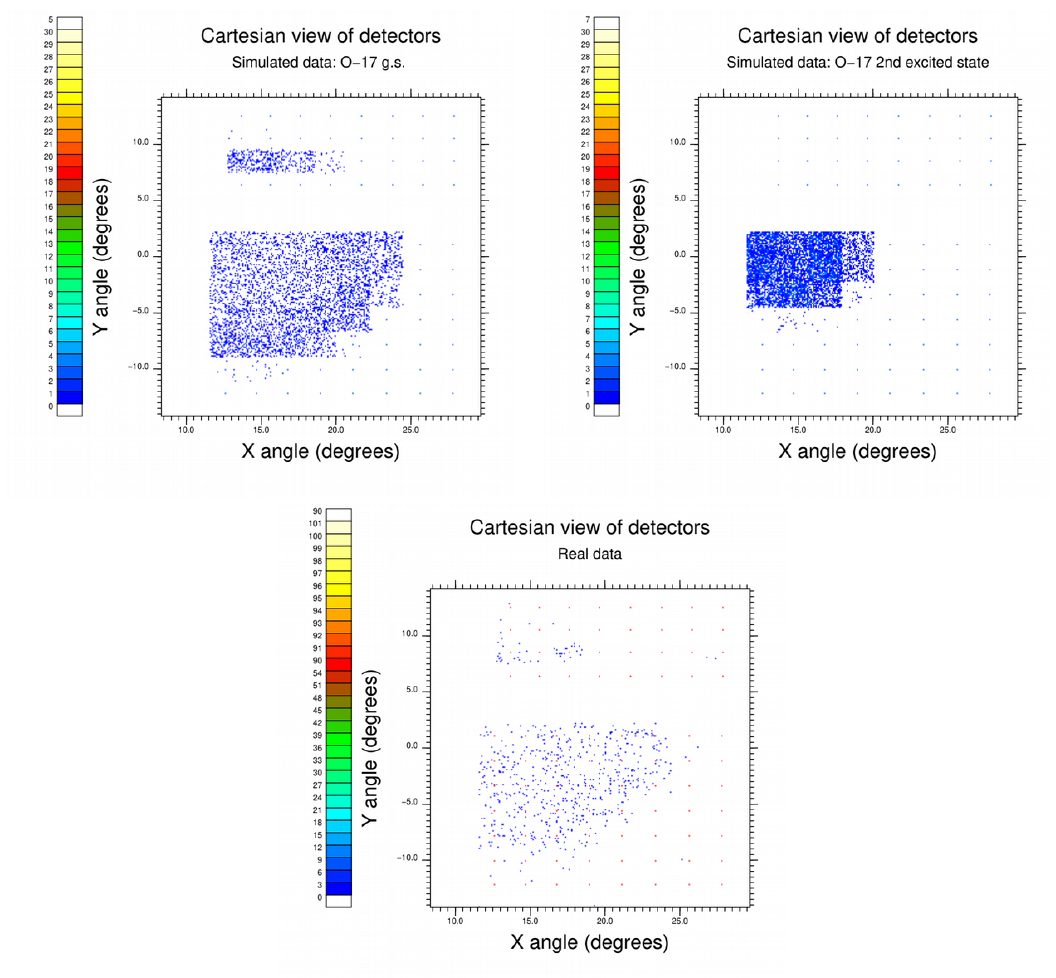
Figure 3: A comparison of Monte Carlo data for the n -decay of the 11.855 MeV state in 18 O, both to the ground state (top left) and the 3.055 MeV state (top right) of 17 O, to real data (bottom). A much better agreement to the ground state Monte Carlo data can be observed. The centres of the individual pseudo-pixels are also indicated by the grid of